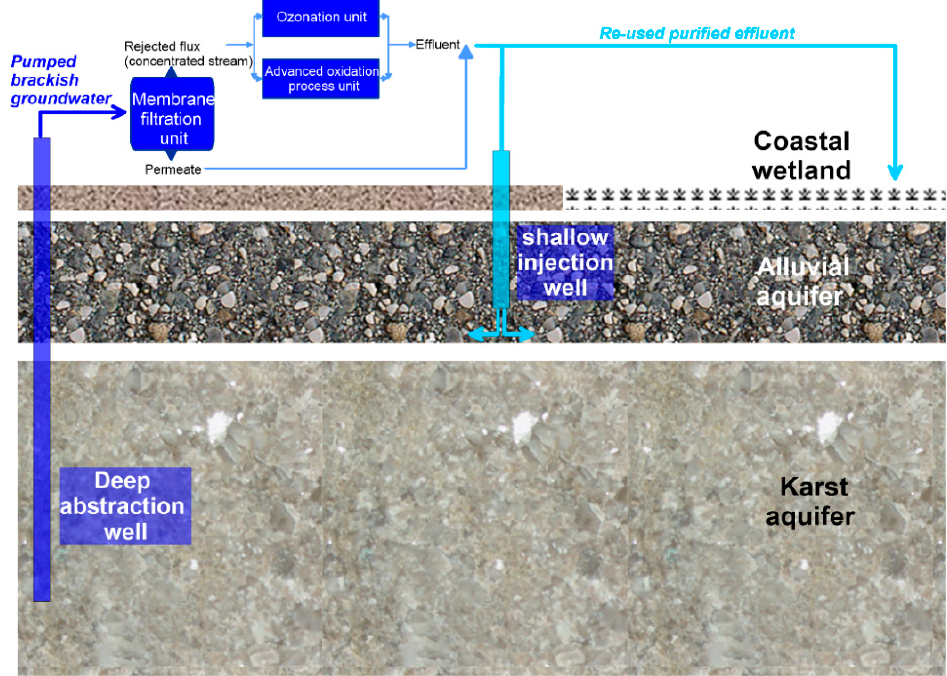
Figure 3. Schematic representation of experimental setup in Schinias pilot